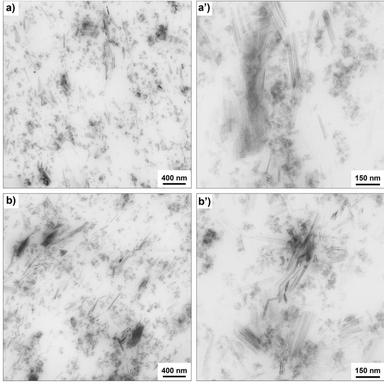
TEM images at different magnifications of (a, a') mSep+SiO2/NR and (b, b') MB-mSep+SiO2/NR samples.